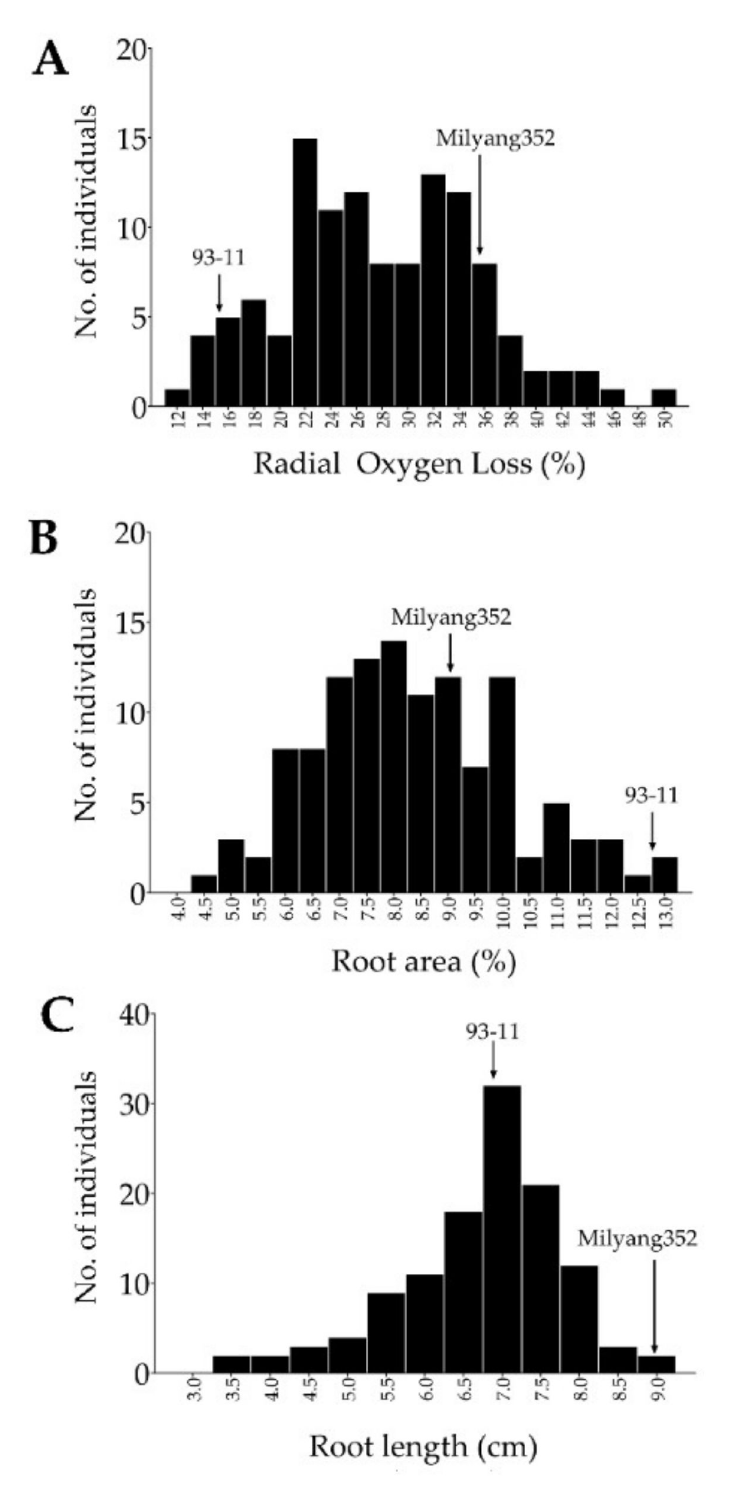
Figure 1. Frequency distribution of traits. ( A ) Frequency distribution of radial oxygen loss (ROL) of a doubled haploid (DH) population grown on FeS. ( B ) Frequency distribution of root area (RA), and ( C ) frequency distribution of root length (RL) under the same